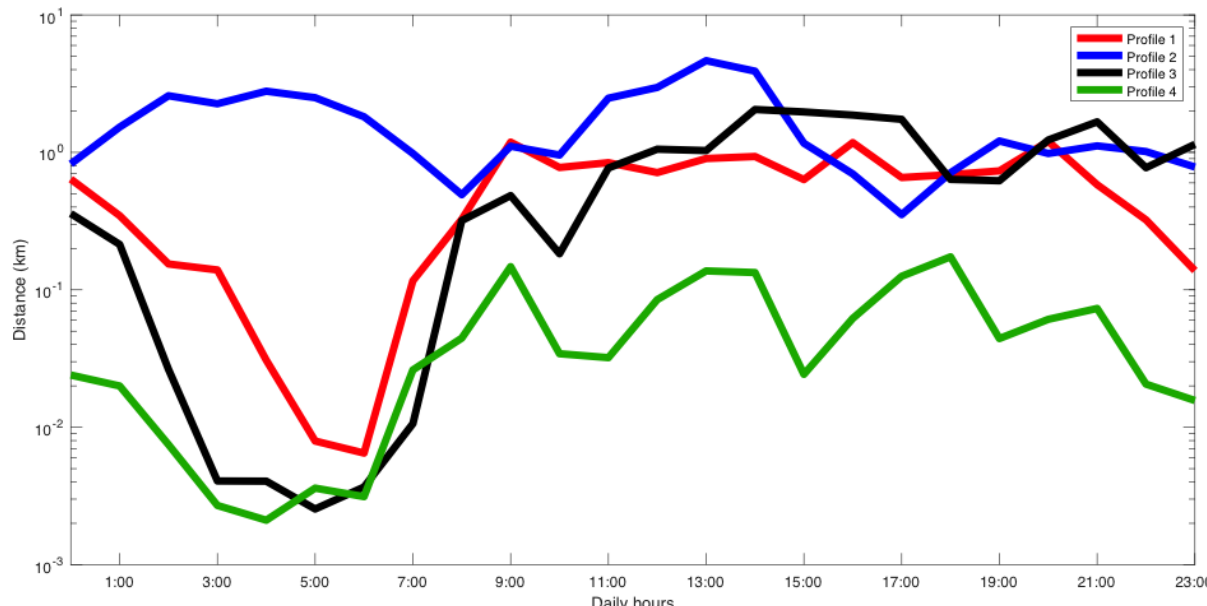
Figure 7. Distance traveled profiles of patient C.